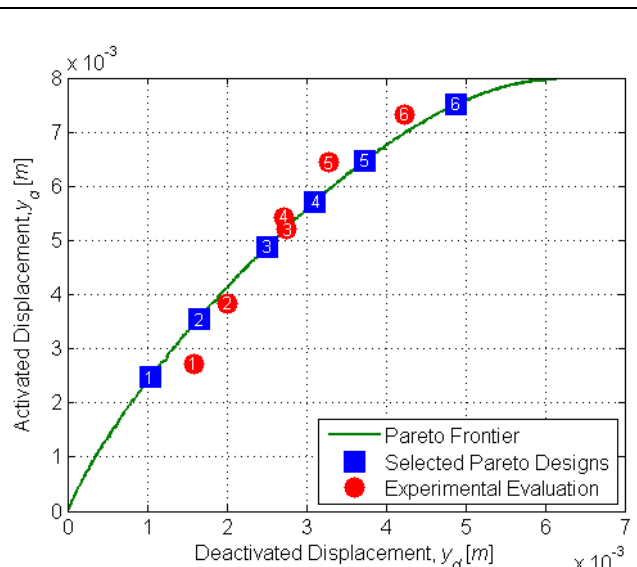
Figure 20. Pareto frontier: Comparing selected Pareto-optimal designs to their experimental evaluation.